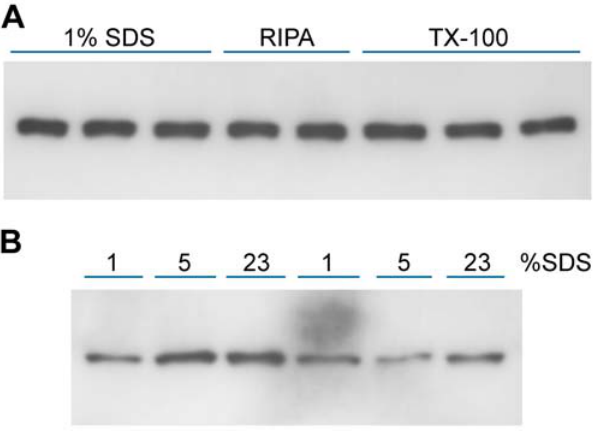
Figure 2. Extraction of cyclin B1 in various lysis buffers. Equal numbers of dissociated PC3 cells were solubilized in lysis buffer containing RIPA, Triton X-100 or SDS (see Materials and Methods) and analyzed for cyclin B1 by Western blot ( A ). Increasing the SDS level to 23% did not release more cyclin B1 ( B ). There was some variability between lanes but, based on multiple gels, it was clear that cyclin B1 was readily extracted by all methods.